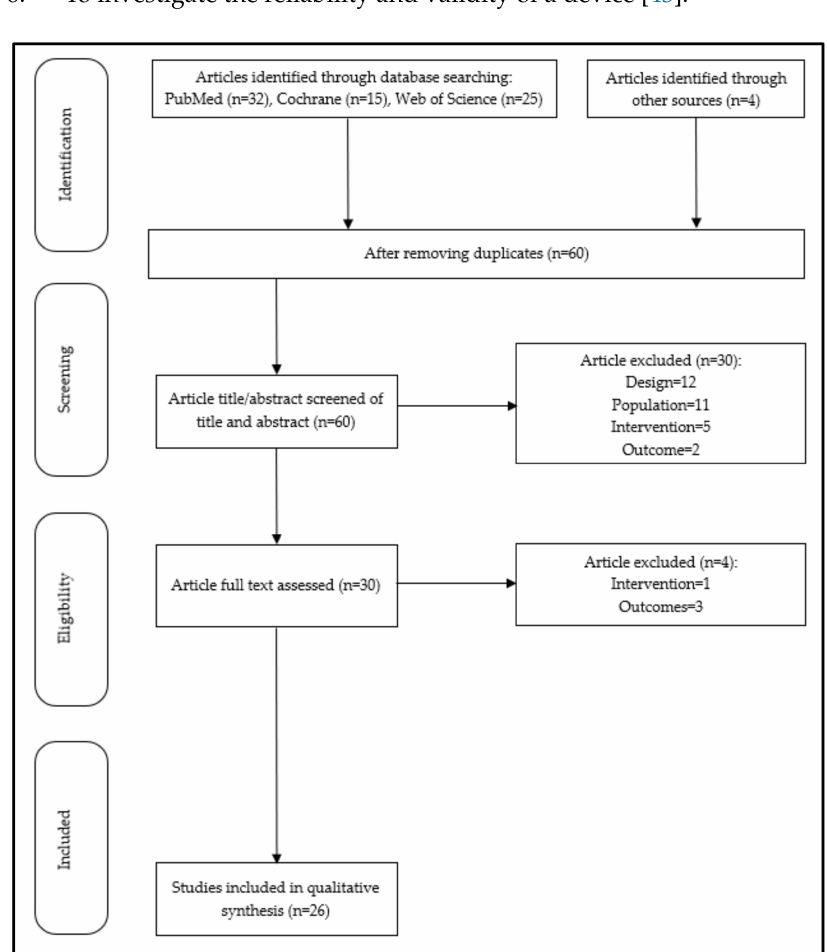
Figure 1. Flowchart of study selection. A total of 26 studies were included according to the eligible criteria in the synthesis.